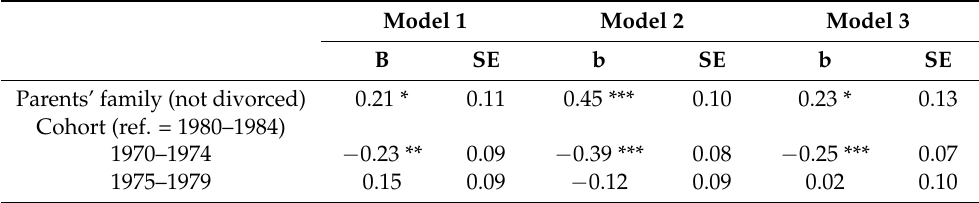
Table A1. Respondent’s educational attainment conditional to parents’ family structure and cohort.